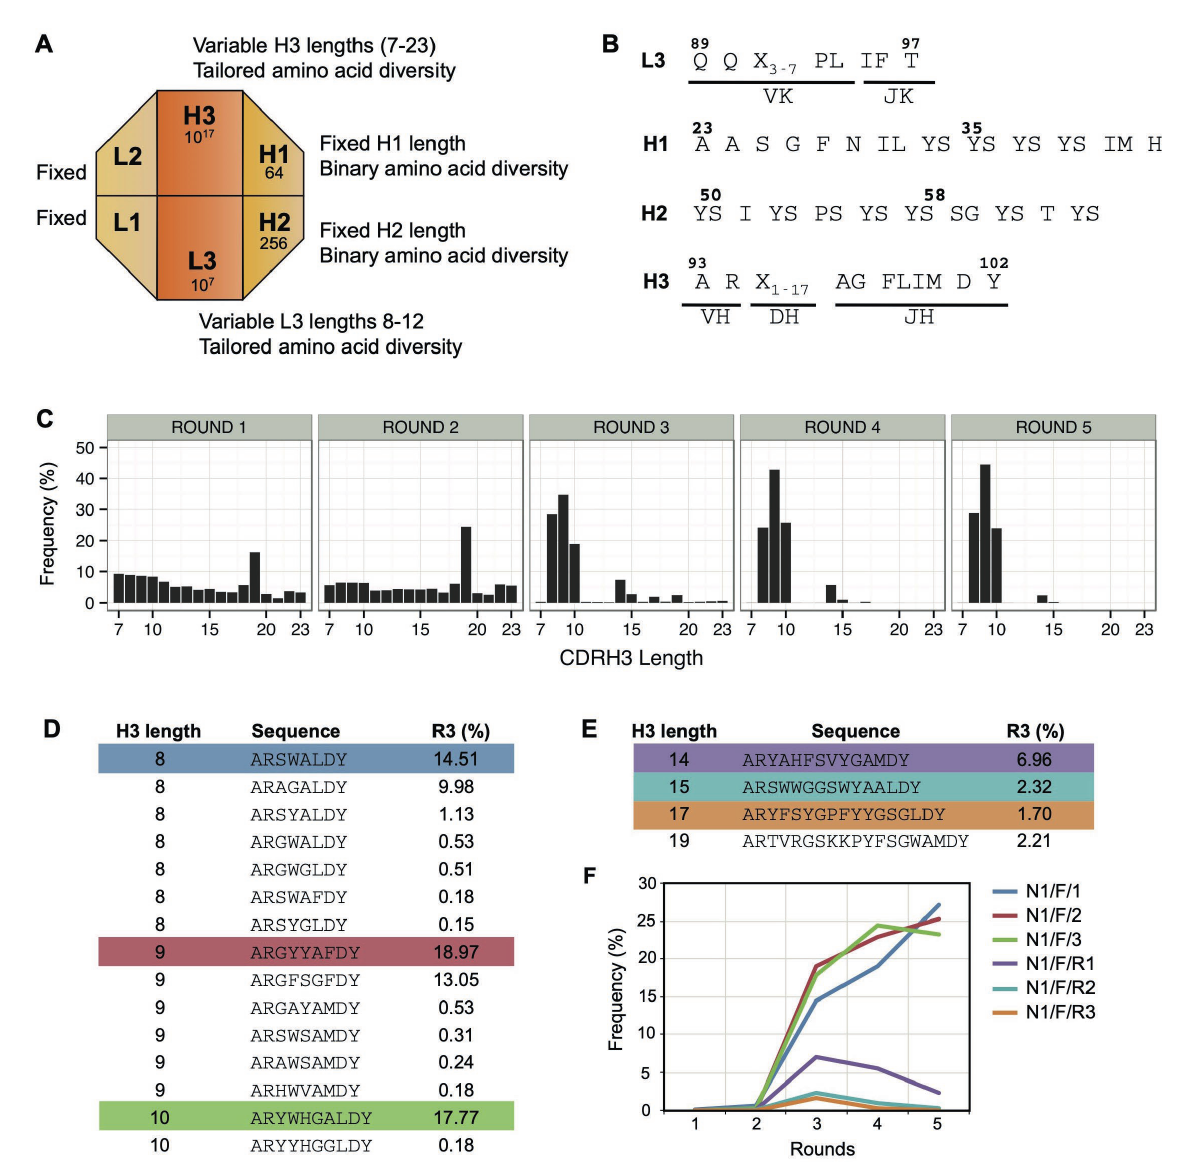
FIGURE 2 Panning Library-F against Notch-1. (A) Schematic representation of Library-F CDR diversity. (B) CDR diversity designs for L3, H1, H2, and H3. X denotes any of the following nine amino acids introduced at different proportions: Y (25%), S (20%), G (20%), A (10%), F (5%), W (5%), H (5%), P (5%), or V (5%). CDRL3 and CDRH3 lengths are varied by altering the number of X. (C) Changes in CDRH3 length distribution over five subsequent phage display rounds for the Notch-1 selection. The peak in rounds 1 and 2 (CDRH3 length of 19 residues) is due to the presence of anti-MBP Fab CDRH3 sequence from the template phagemid. (D) CDRH3 sequences >0.1% in round 3 with short loop lengths (8, 9, and 10 amino acids). (E) CDRH3 sequences >0.1% in round 3 with loop lengths of 14, 15, 17, and 19 amino acids. In panels D,E , the most abundant sequence from each CDRH3 length is highlighted. (F) Propagation behavior of highlighted CDRH3 sequences over five rounds of